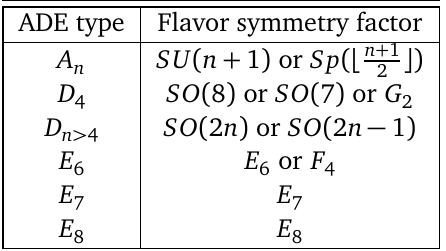
Table 4: The list of possible (maximal) flavor symmetry factors from a codimension- two singularity with type ADE, which can be different from the actual 5d flavor sym- metry G . For a given type, the rank of flavor symmetry factor is determined by the F number of different non-compact divisors (conjugacy classes in Γ ) associated to a 1, f single codimension-two ADE singularity. ADE type Flavor symmetry factor A n SO ( 8 ) or SO ( 7 ) or G